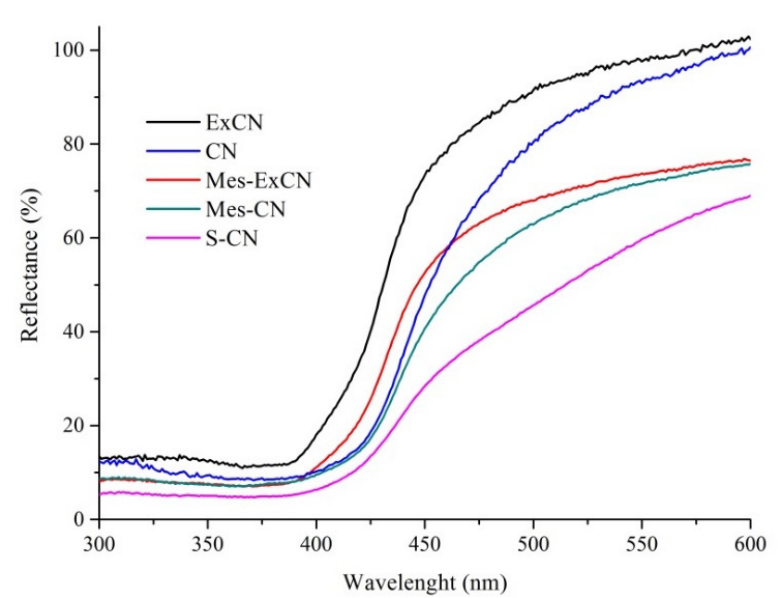
Figure 1. UV / vis di ff use reflectance spectra of carbon nitride (CN)-based Figure 1. UV/vis diffuse reflectance spectra of carbon nitride (CN)-based nanomaterials.